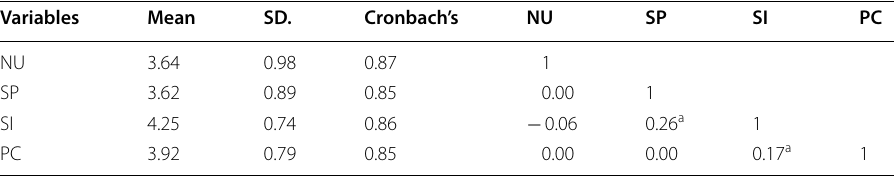
NU need for uniqueness, SP self-promotion, SI social identity, PC perception of customization a Correlation is significant at the 0.05 level (2-tailed)